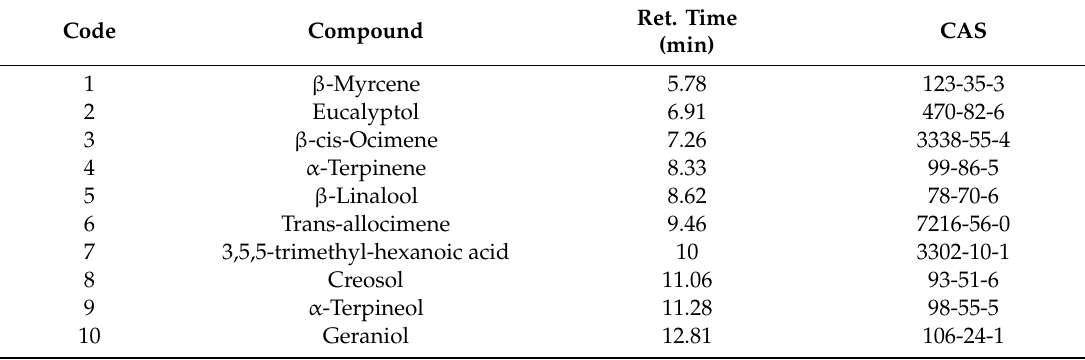
Figure 4. Chromatographic profile for ( a ) Condensate 1 (black) and Condensate 2 (red) and ( b ) detailed characterization for Condensate 1. SPME-GC-MS analysis. Table 3. Identified compounds in the Condensate 1 sample. SPME-GC-MS